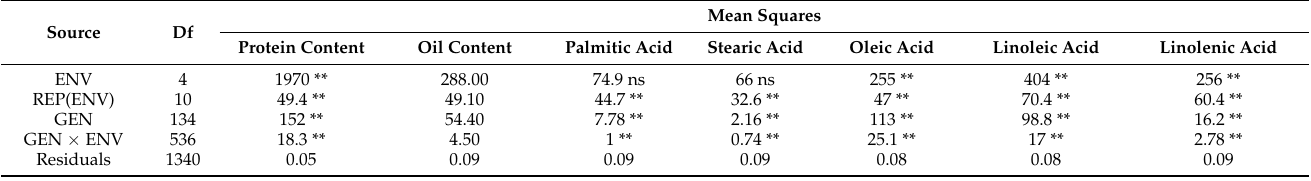
Table 1. Combined analysis of variance for seven seed compositions of 135 genotypes across the five environments.